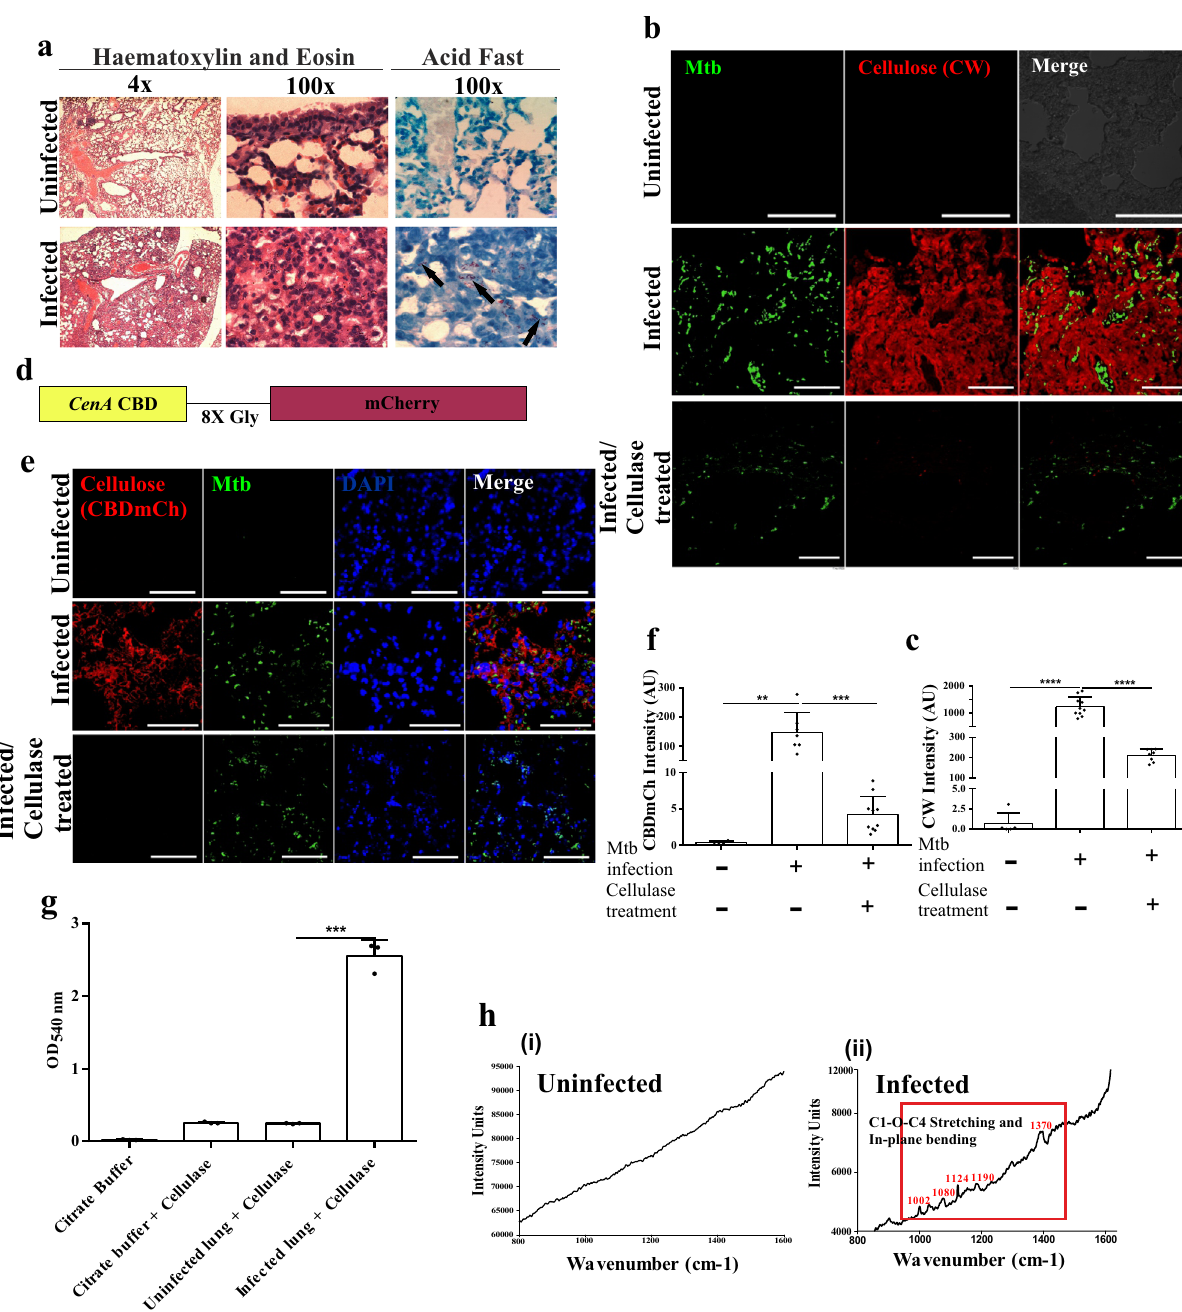
Fig. 5 Mtb forms bio fi lms inside the mice lungs. a Histopathology of granulomatous lesions in the lungs of Mtb infected mice ( n = 5) in contrast